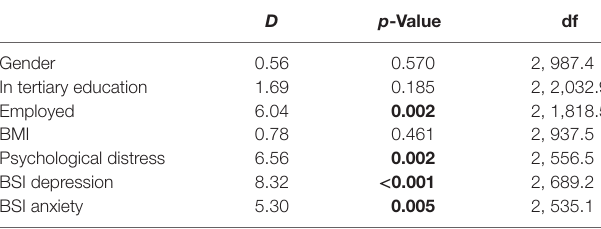
TaBle 8 | Pooled estimates from pseudo-class analyses where class assignments were sampled 100 times from the posterior class probabilities. D p -Value df